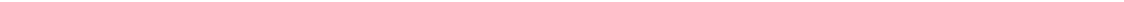
Fig. 1 P . protegens swarms to C . reinhardtii and leads to growth arrest and changes in algal morphology. a Co-cultivation of C . reinhardtii and bacteria on agar plates after 3 days reveals the inhibitory effect of P . protegens . Suspensions of different bacteria were applied to restricted areas of a plate that contains C . reinhardtii within a top layer of TAP agar. LB medium was used as control. b Liquid co-cultivation at indicated ratios of algae to bacteria used for